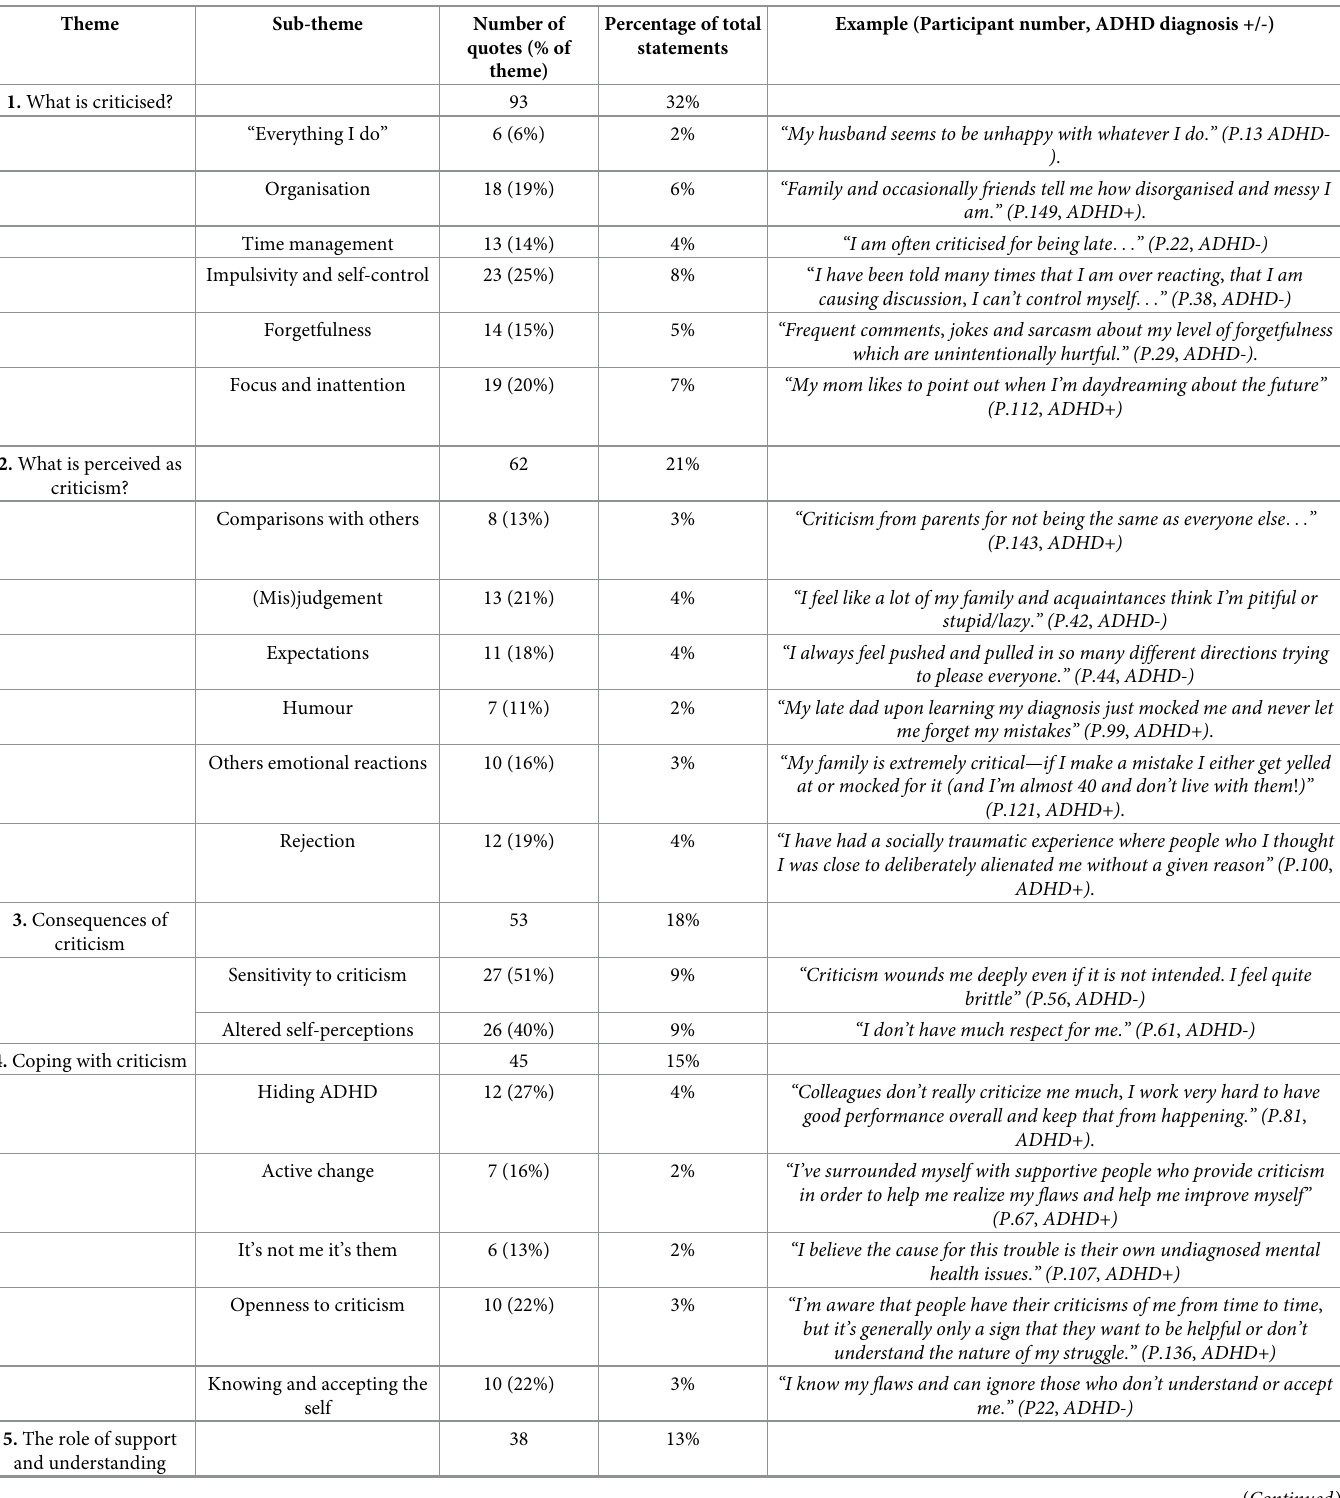
Table 2. Themes identified, sub-themes, how many references correspond to each sub-theme, and an example of each sub-theme.